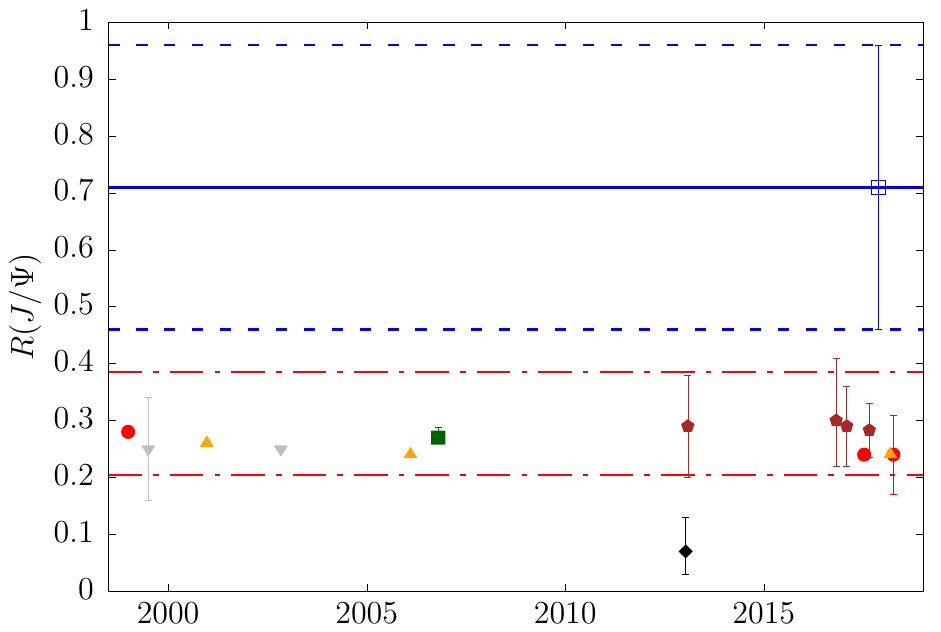
Figure 4 . R ( J/ψ ) from the LHCb experiment (blue open square, 1 σ uncertainty denoted by blue dashed lines), our bound (red dash-dotted lines), and models (points colored by model type), as listed in table